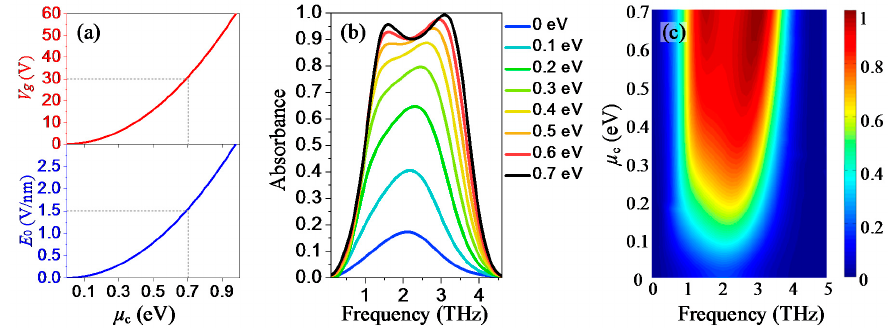
Figure 7. ( a ) displays the relationship between μ c and E 0 , μ c and V g . ( b ) and ( c ) show the simulated absorption spectra curves and colormap with different Fermi levels from 0 eV to 0.7 eV for both TE and TM polarizations, respectively.